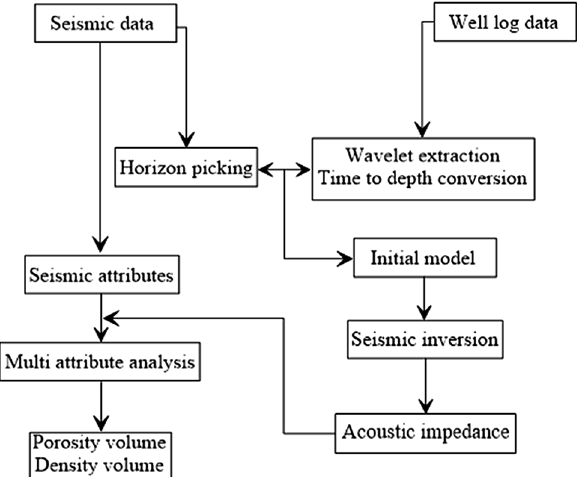
Fig. 3 Flowchart of seismic inversion and multi-attribute analysis